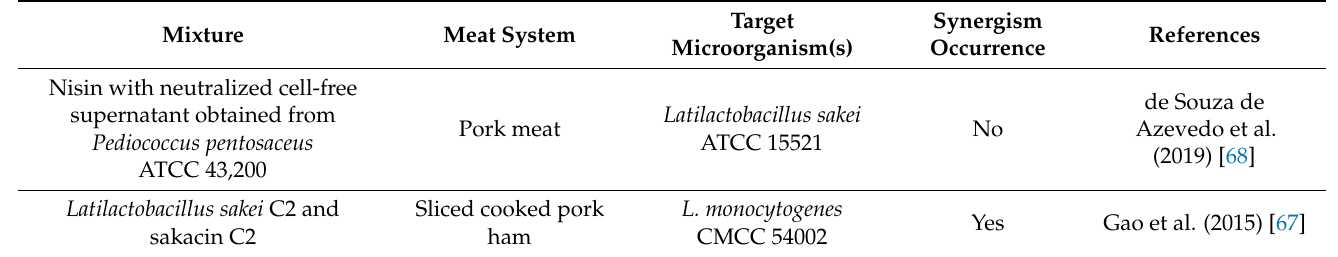
Table 5. The use of diverse combinations of bacteriocins with non-starter protective cultures against different target